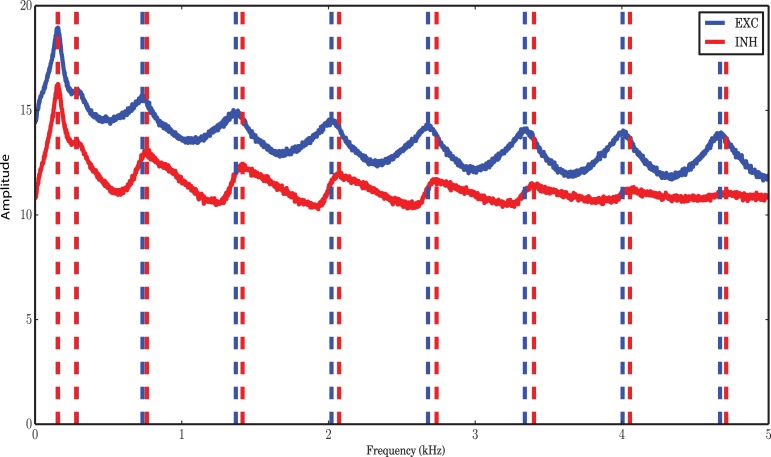
Amplitude spectral density of spike counts with a bin size of 0.1 ms and d = 1.5 ms. The entire spectrum of excitatory spike counts in bins of 0.1 ms is plotted in blue. The power spectrum of inhibitory spike counts under the same condition is plotted in red. Due to less number of neurons in the inhibitory population, its amplitude is lower than that of excitation. Dashed lines are plotted at frequencies corresponding to the peakes in the power spectra. For low frequencies, the peaks of the two spectra are the same. In the high frequency range the peaks in the amplitude spectrum of the inhibitory spike counts are slightly shifted with respect to those of excitatory ones.